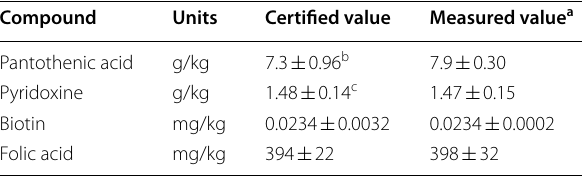
Table 3 Results for pantothenic acid, pyridoxine, and biotin obtained by the developed ID–LC/MS method in a SRM 3280 (multivitamin/multielement tablets)